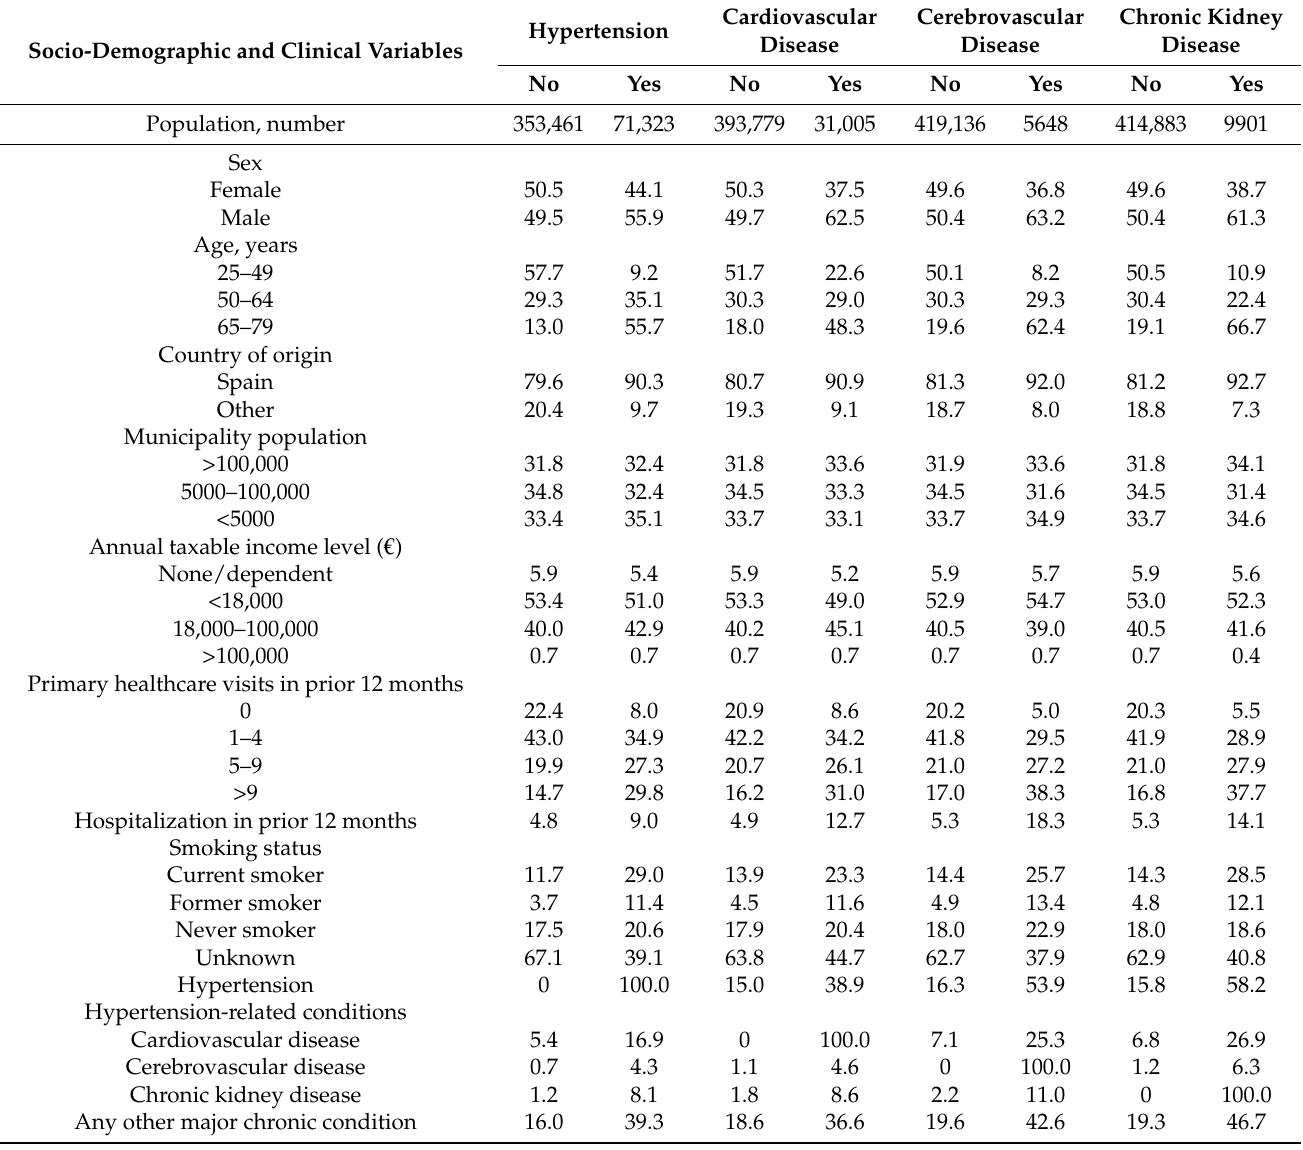
Table 1. Characteristics (in percentages) of the cohort population with and without prior diagnosis of hypertension, cardiovascular disease, cerebrovascular disease and chronic kidney